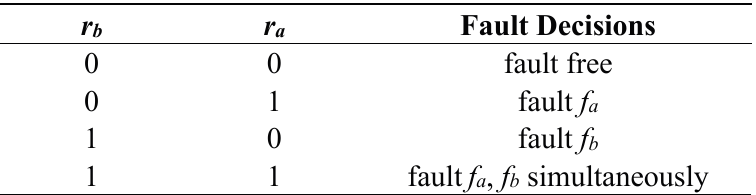
Table 1. Fault diagnosis decision